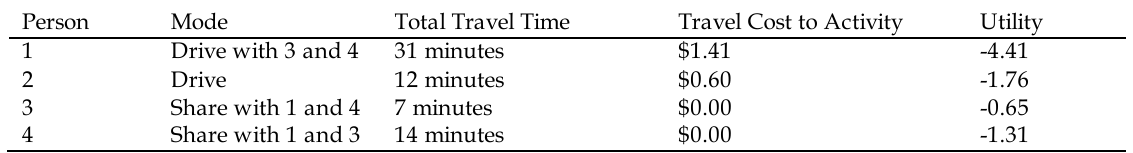
Table 5. Calculation of Household Utility in Chaperone Allocation